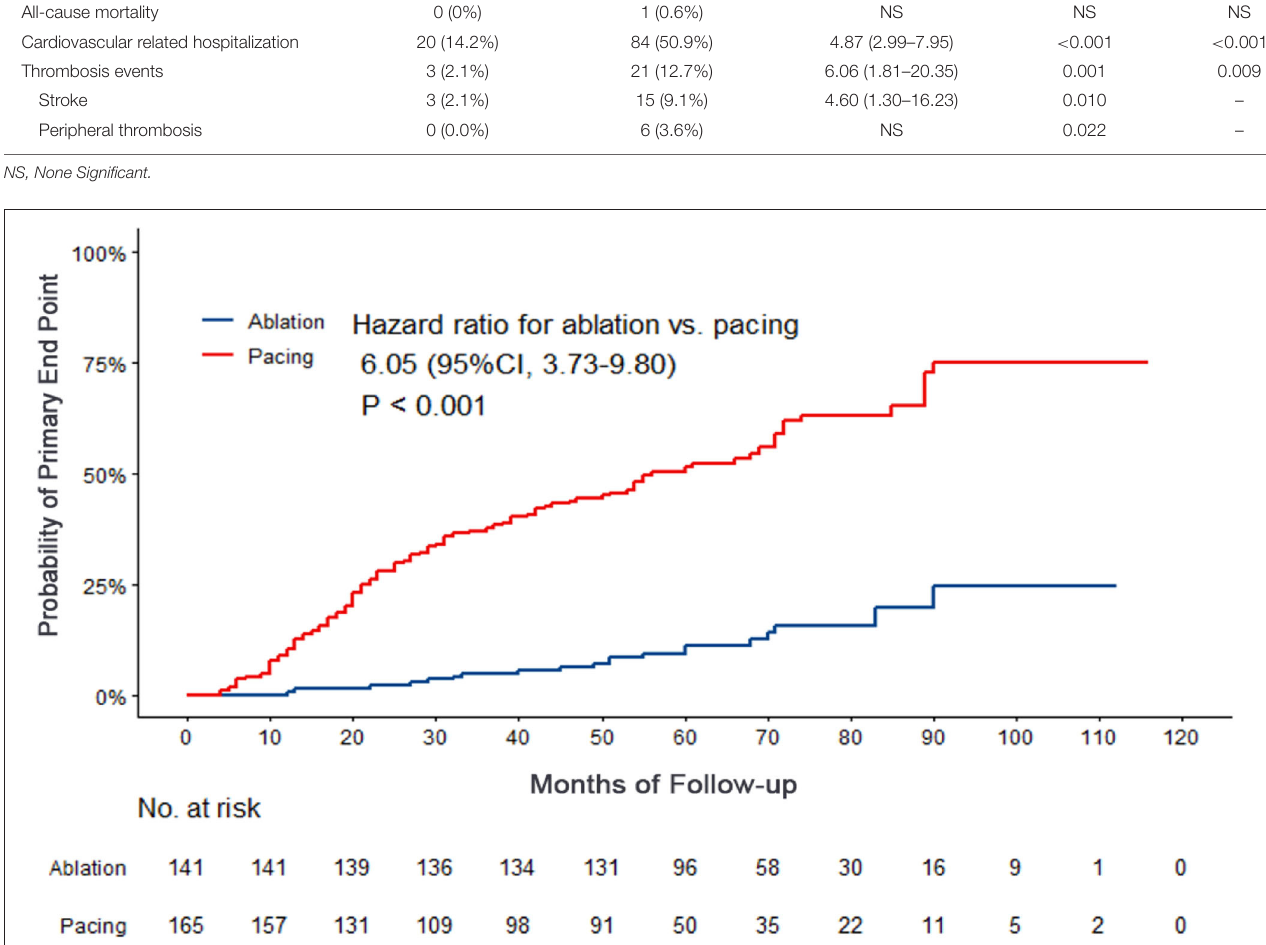
FIGURE 2 | Kaplan–Meier curves comparing probability of the primary end point. Month 0 is the time of the baseline visit. The panel shows the probability of composite end events (cardiovascular related hospitalization or thrombosis